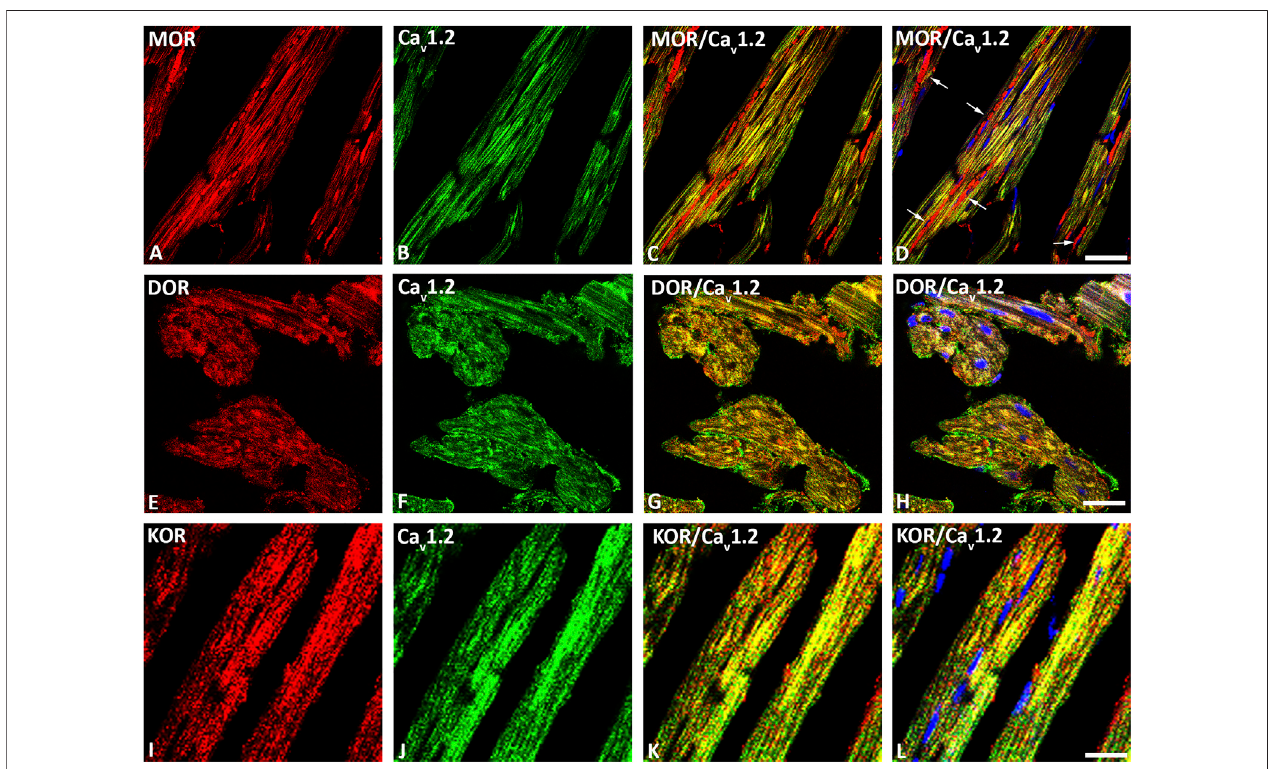
FIGURE 1 | Double immuno fl uorescence confocal microscopy of opioid receptor mu (MOR) (A) , delta (DOR) (E) , and kappa (KOR) (I) (Texas red immuno fl uorescence)withL-typeCa 2+ -channel Cav1.2(FITC green fl uorescence) (B , F , J) inrat leftventricular myocardium. Note thatrows ofmitochondria arelocated between cardiomyocytes and are immunostained for MOR as indicated by the red fl uorescence (arrow) (D) . Nuclei identi fi ed by their bright blue using DAPI staining (D , H , L) . (C – L) show the colocalization of opioid receptor subtypes mu, delta and kappa together with the L-type Ca 2+ -channel Cav1.2 on cardiomomyocytes of the left ventricle. Bar = 20 μ